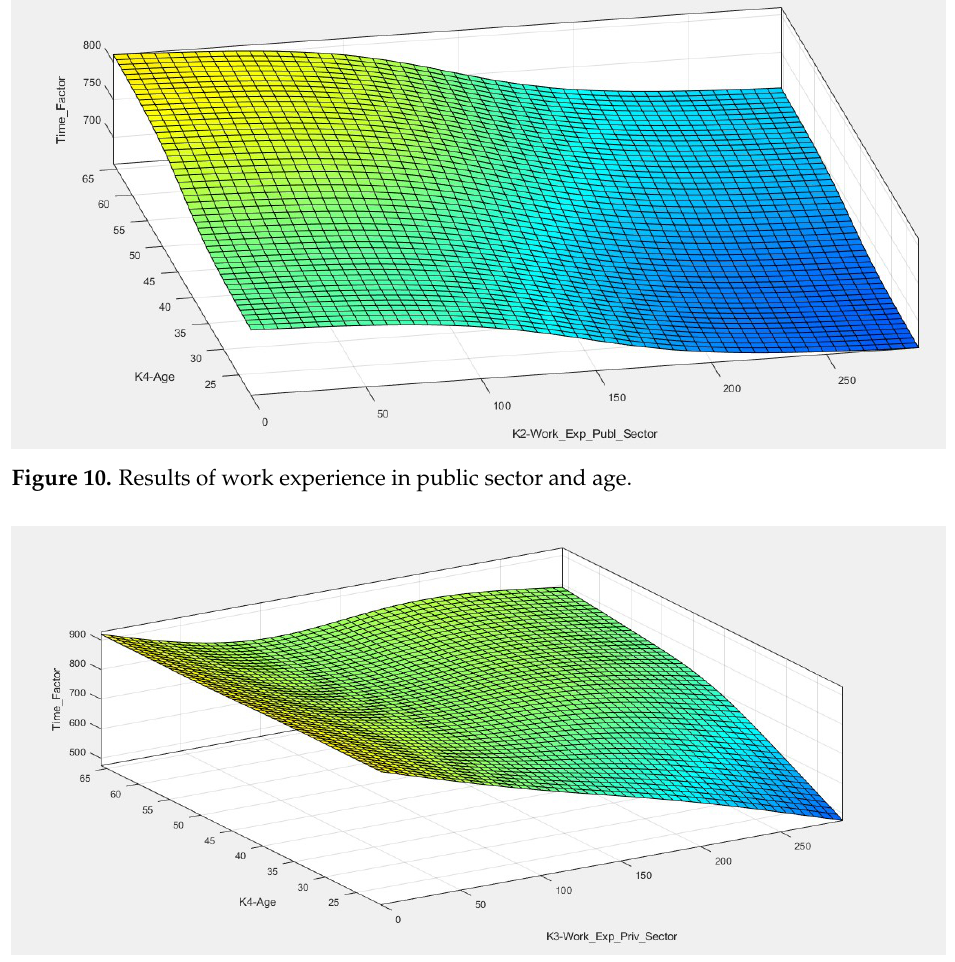
Figure 11. Results of work experience in private sector and